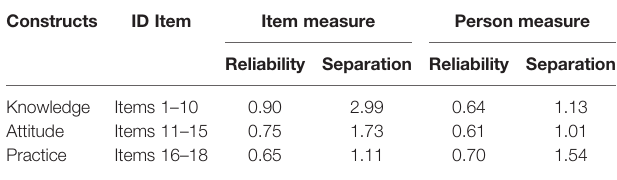
TABLE 4 | Reliability and separation indices for healthcare workers ’ knowledge, attitudes, and practices instrument for uncomplicated malaria containing 18 items using Rasch model (N =